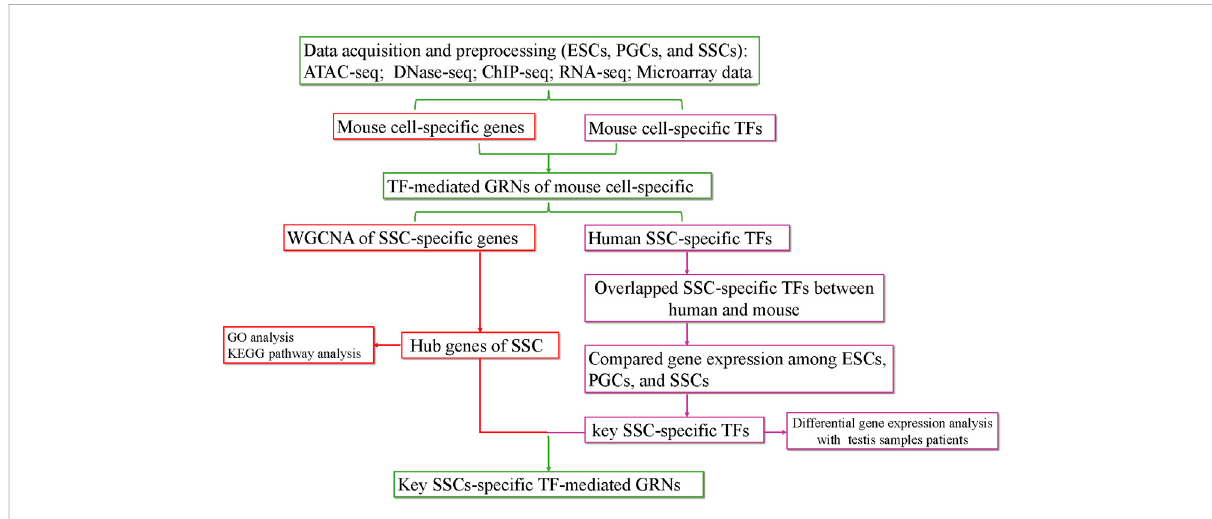
FIGURE 1 The fl ow chart of the analysis process. KEGG, Kyoto Encyclopedia of Genes and Genomes; GO, Gene